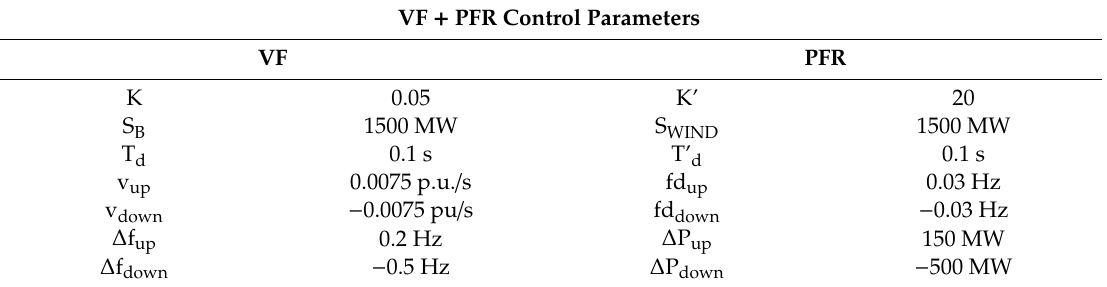
Table 1. The parameters in VF + PFR control (Group 1).